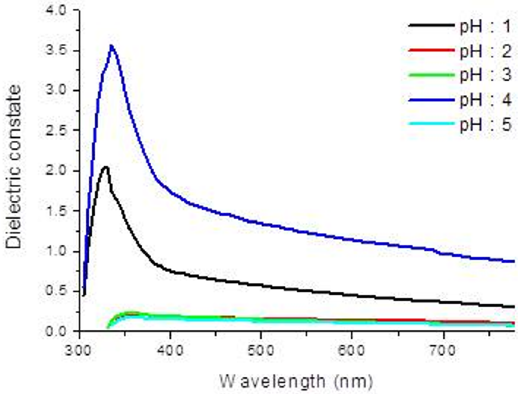
thin films produced at x